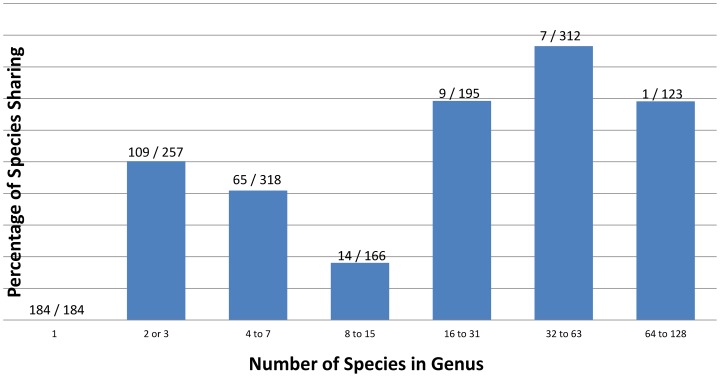
Impact of genus size on DNA barcode performance.The relationship between the number of species in a genus (plotted on a log2 scale) and the incidence of barcode sharing. Values above the bars indicate the number of genera and the number of species in each log2 category.